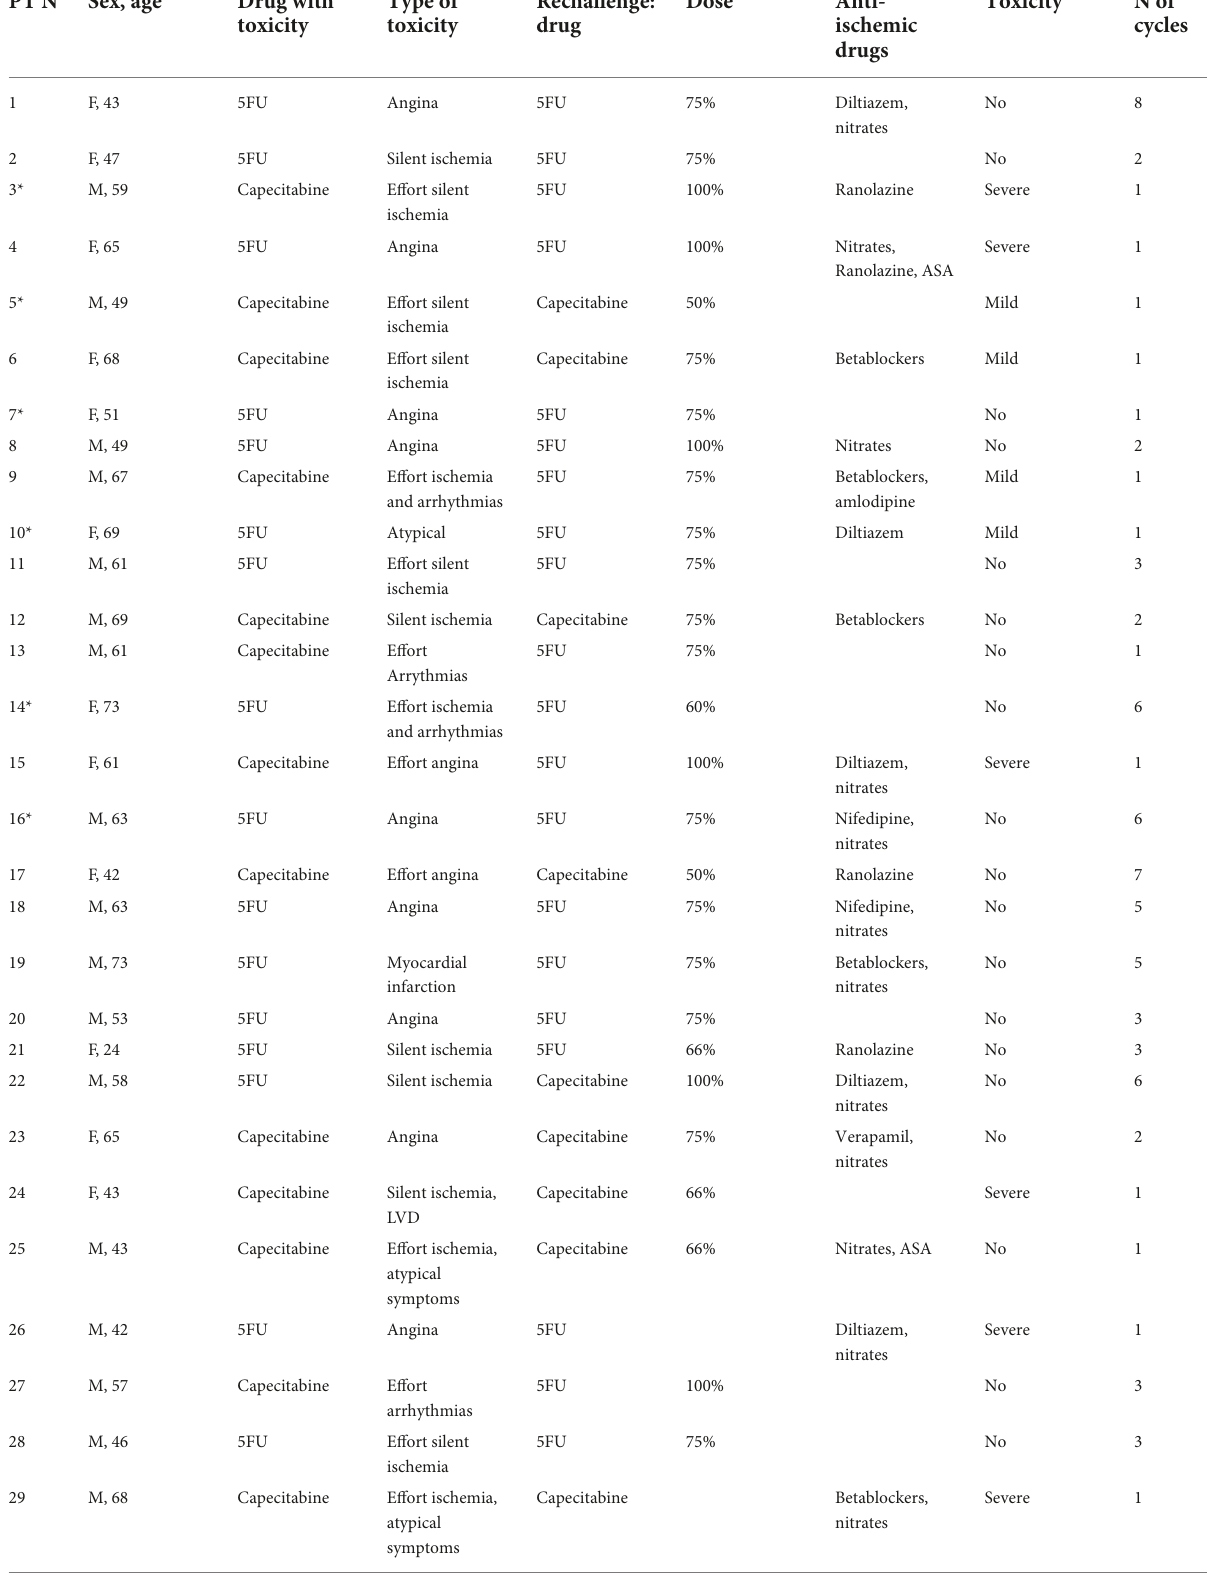
TABLE 5 Patients with rechallenge chemotherapy after